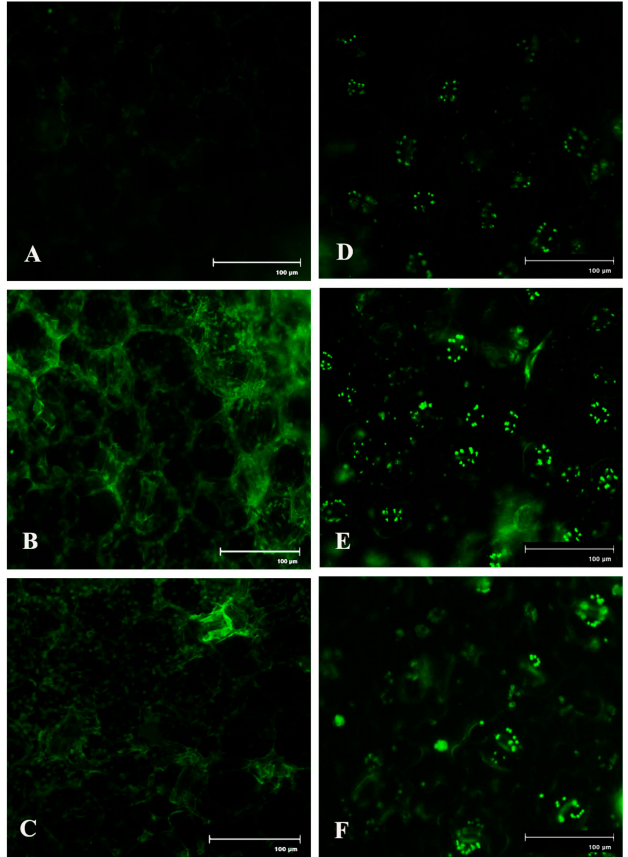
Figure 7. E ff ects of C. gloeosporioides on production of NO in detached bean leaf. Real-time NO generation was detected by green fluorescence in the section of leaf petiole ( A – C ) and leaf epidermal cells stained by 4-5 diaminofluorescein diacetate (DAF-2DA): ( A , D ) 0 dai; ( B , E ) 2 dai; ( C , F ) 4